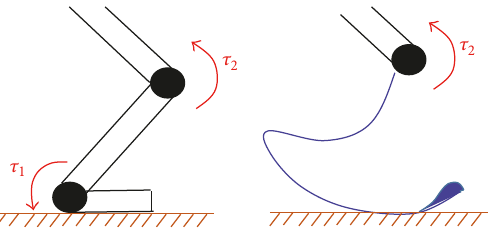
Figure 3: Correlation between leg of solid robot and elastic leg of AR.